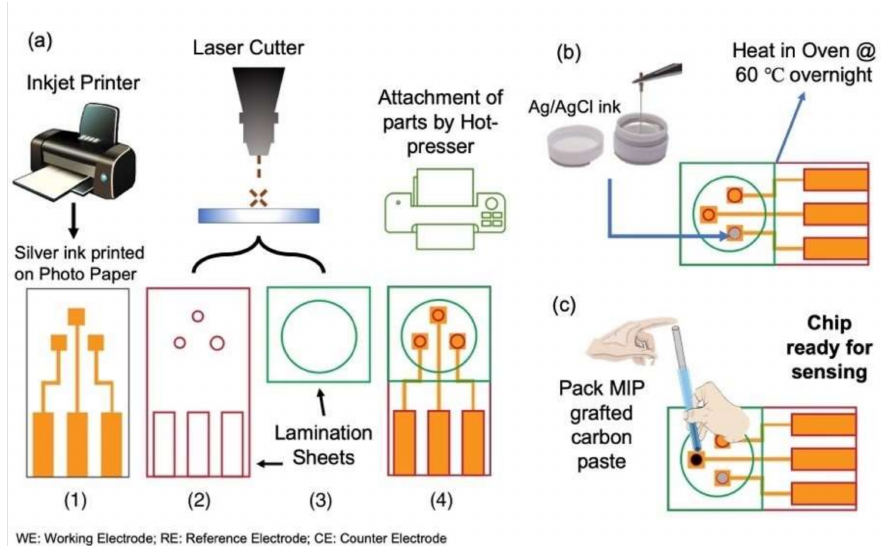
Figure 9. Scheme of the procedure for fabricating the disposable sensor chip. ( a ) Making of chip sensor using paper and PET, ( b ) packing the reference electrode, Ag/AgCl and ( c ) packing the MIP as the working